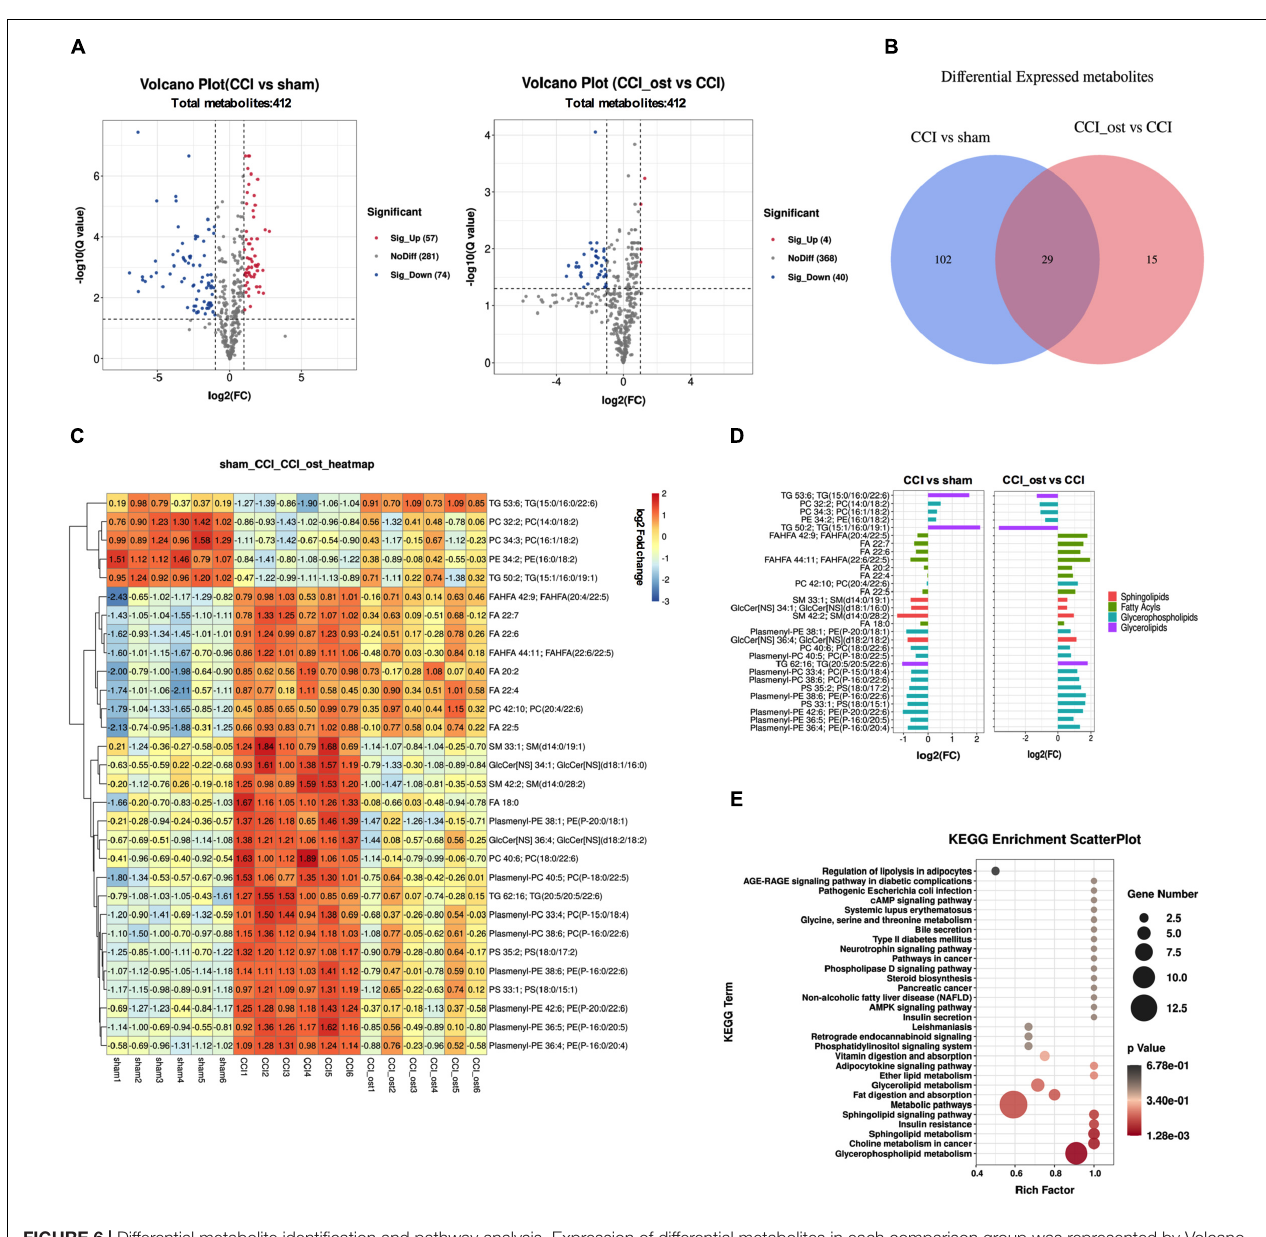
FIGURE 6 | Differential metabolite identification and pathway analysis. Expression of differential metabolites in each comparison group was represented by Volcano plot (A) , Venn diagram (B) , heat maps (C) , and FC histogram (D) . (E) Kyoto encyclopedia of genes and genomes (KEGG) analysis was used to enrich the pathway of differential metabolites. Data were calculated by the Pearson correlation method after mean centering and unit variance